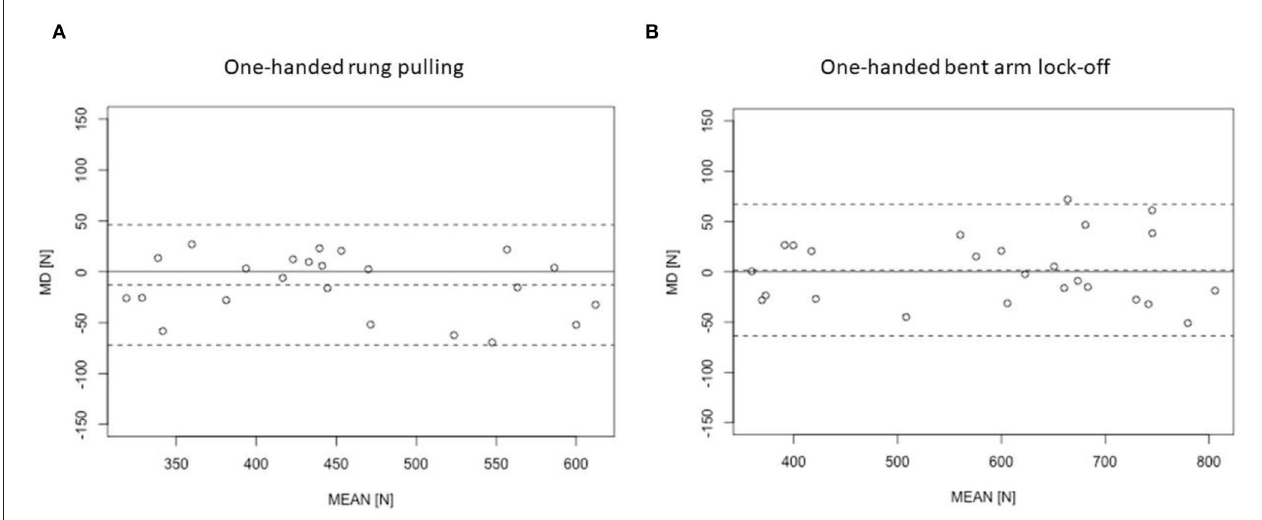
FIGURE 2 | The Bland–Altman plots [MD, mean difference between both testing conditions (free and fixed); MEAN, average of both conditions] for the validity of the testing conditions measured via Kistler force plate for (A) one-handed rung pulling and; (B) one-handed bent arm lock-off. The dashed line indicates 95% limit of agreement. The first test session is displayed.